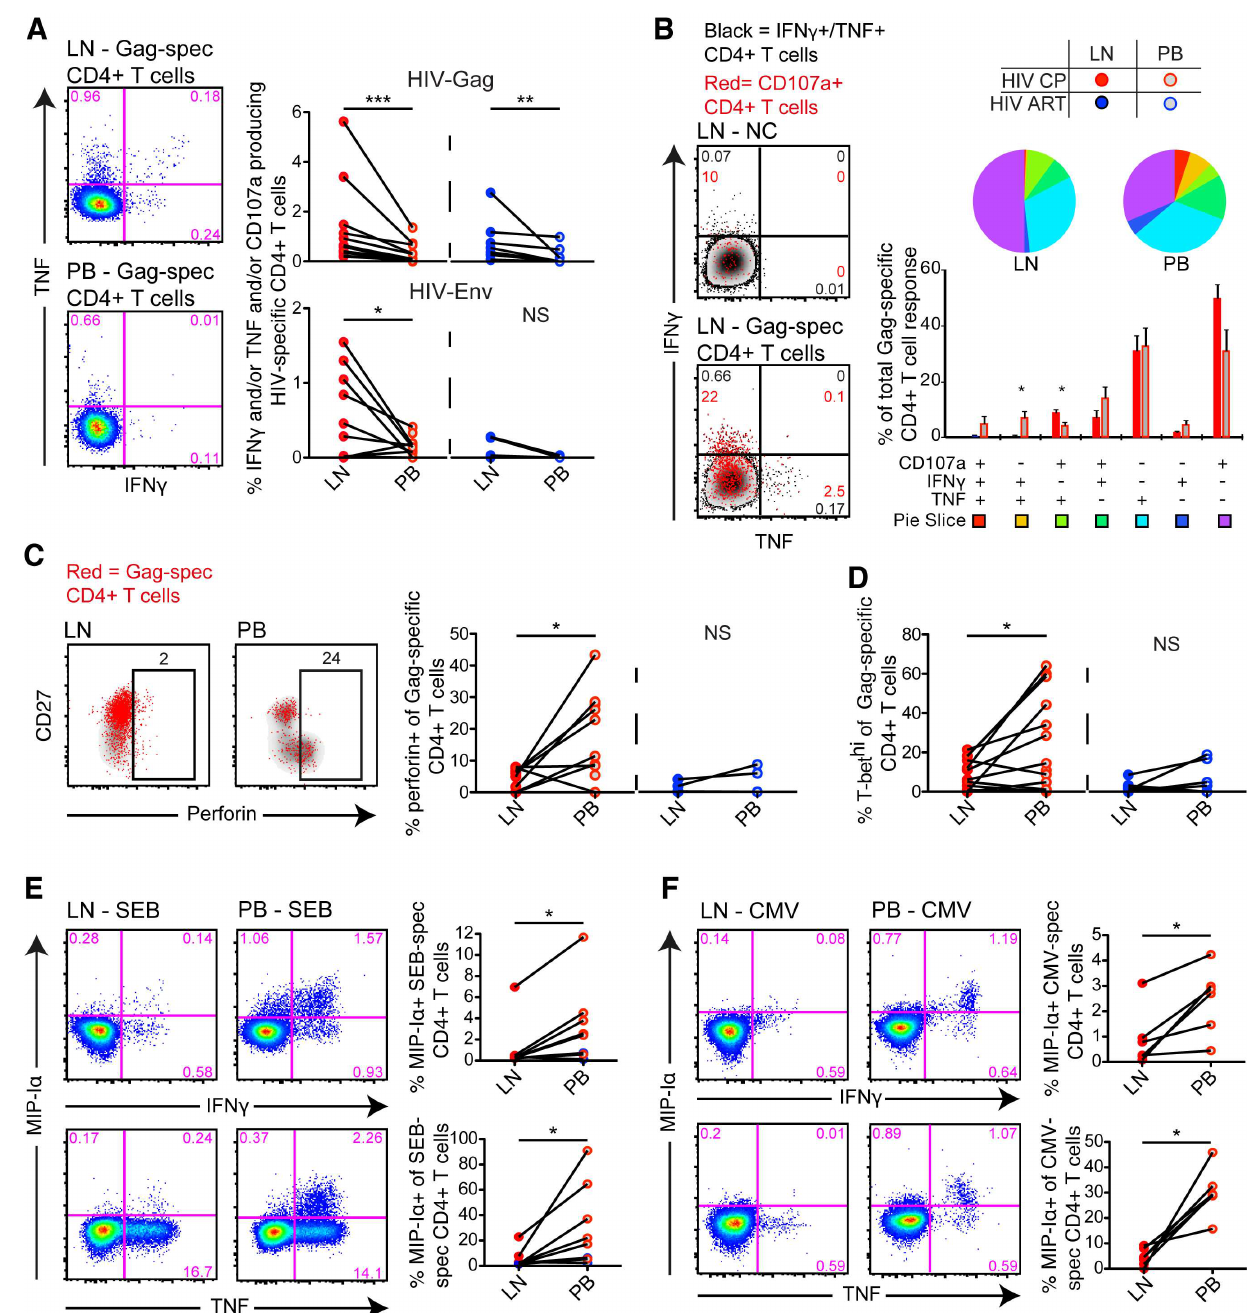
Fig 4. Functional characteristics of polyclonal and virus-specific effector CD4+ T cell responses in HIV-infected LNs and blood. (A) Flow cytometry plots (HIV ART+ subject) and plots for matched HIV-Gag or–Env-specific CD4+ T cell responses in HIV-infected LN and PB. (B) Flow cytometry plots (HIV-infected CP) showing the negative control (NC) and Gag-specific response of LN CD4+ T cell response. The high abundance of CD107a (red) that is not co-expressed with IFN γ or TNF is illustrated in this example. SPICE analysis of functional combination between LN (red) and PB (red-gray) Gag- specific CD4+ T cell responses for HIV-infected CPs and ART+ subjects. (C) Flow plots (HIV-infected CP) of Gag-specific CD4+ T cell response (red) from LN and PB in relation to CD27 and perforin expression. Graphs represent the frequency of (C) perforin+ and (D) T-bet hi cells between LN and PB Gag-specific CD4+ T cells. (E) Flow plots (HIV-infected CP) of MIP-1 α versus IFN γ and TNF production for LN and PB SEB stimulated CD4+ T cells. Corresponding plots showing the frequency of MIP-1 α +SEB stimulated CD4+ T cells (top) and MIP-1 α +of IFN γ /TNF/CD107a/MIP-1 α + SEB stimulated CD4+ T cells (bottom). (F) Flow plots (HIV-infected CP) of MIP-1 α versus IFN γ and TNF production for LN and PB CMV-specific CD4+ T cells and corresponding graphs showing the frequency of MIP-1 α +CMV-specific CD4+ T cells (top) and MIP-1 α +of IFN γ /TNF/CD107a/MIP-1 α + CMV-specific CD4+ T cells (bottom). Median and IQR are shown for all bar plots. Permutation test was performed between the pie charts. Wilcoxon